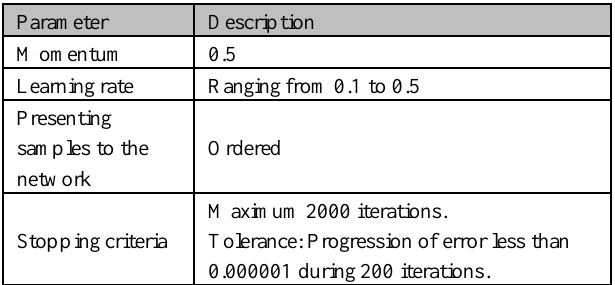
Table 8. Training parameters used for proposed MLP.